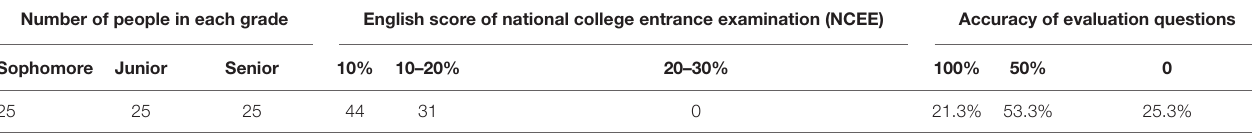
TABLE 1 | Background information of respondents and test results. Number of people in each grade English score of national college entrance examination